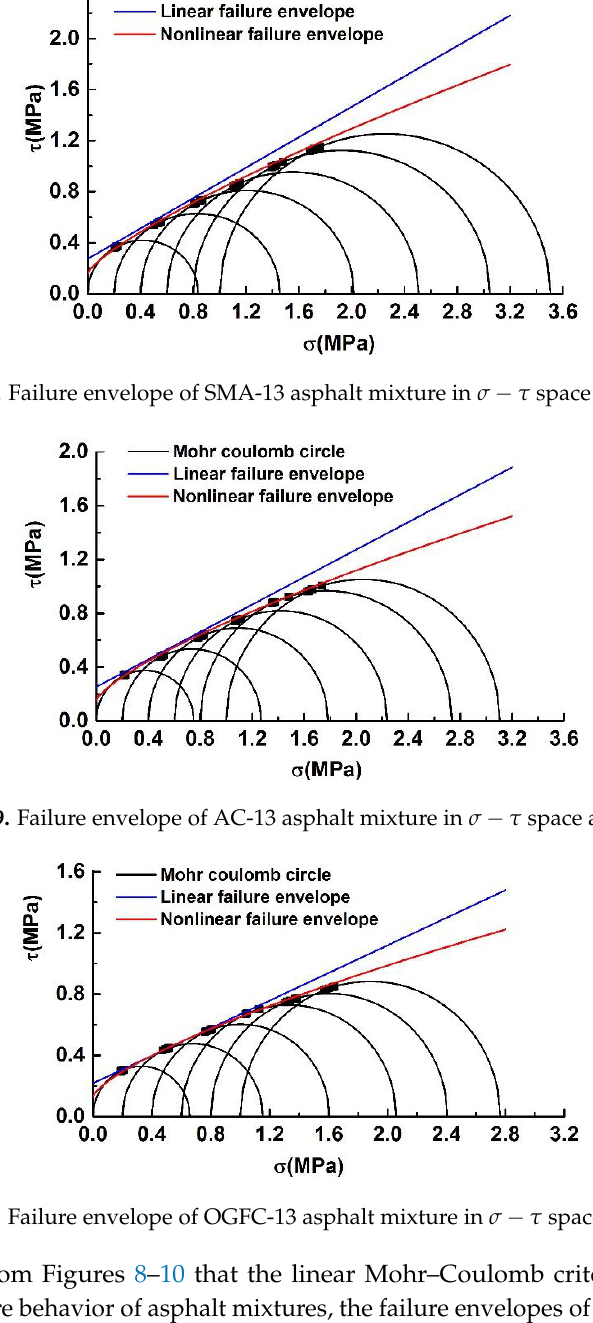
Figure 10. Failure envelope of OGFC-13 asphalt mixture in